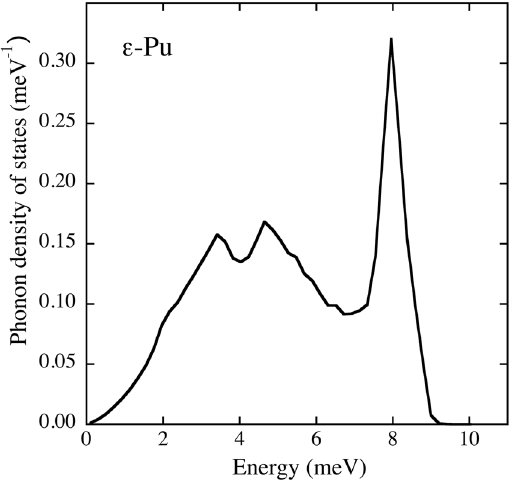
Figure 5. Calculated (T = 900 K) phonon density of states for ε -plutonium at the atomic volume 24.6 Å 3